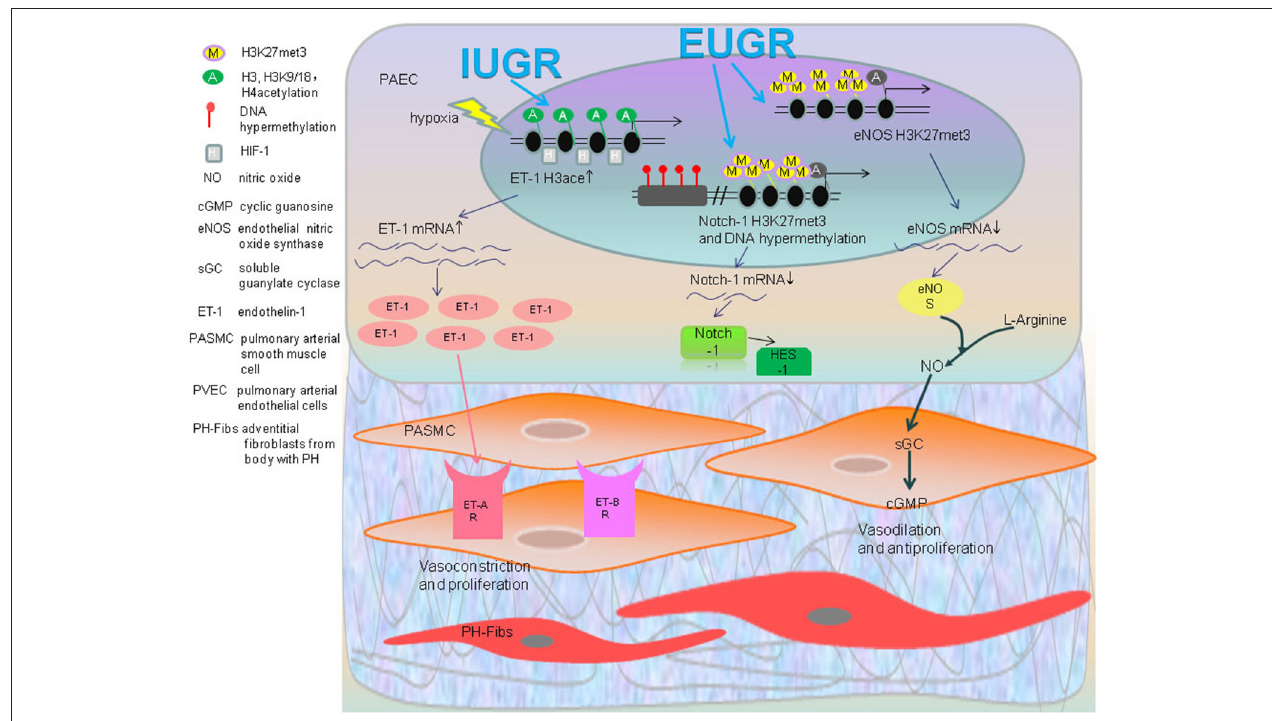
FIGURE 2 | Epigenetic regulatory mechanisms of developmental origin of PAH: IUGR rats become hypersensitive to hypoxia as a result of PH along with an increased expression of ET-1, which is involved in contraction of pulmonary vascular. The acetylation of histone H3, H3K9/18, and H4 of ET-1 gene in IUGR-hypoxia rats PAEC accompanied with enriched transcription factor HIF-1 α was found. The increased ET-1 activates ET receptors in PASMC that results in vasoconstriction and proliferation. In the EUGR induced PAH rat model, the levels of H3K27me3 of the eNOS gene were significantly higher. EUGR also caused H3K27me3 and methylation of a CpG site of Notch1 gene. This decreases the expression of eNOS mRNA, Notch1 mRNA and its downstream gene HES1 as a consequence, which impairs anti-proliferation and